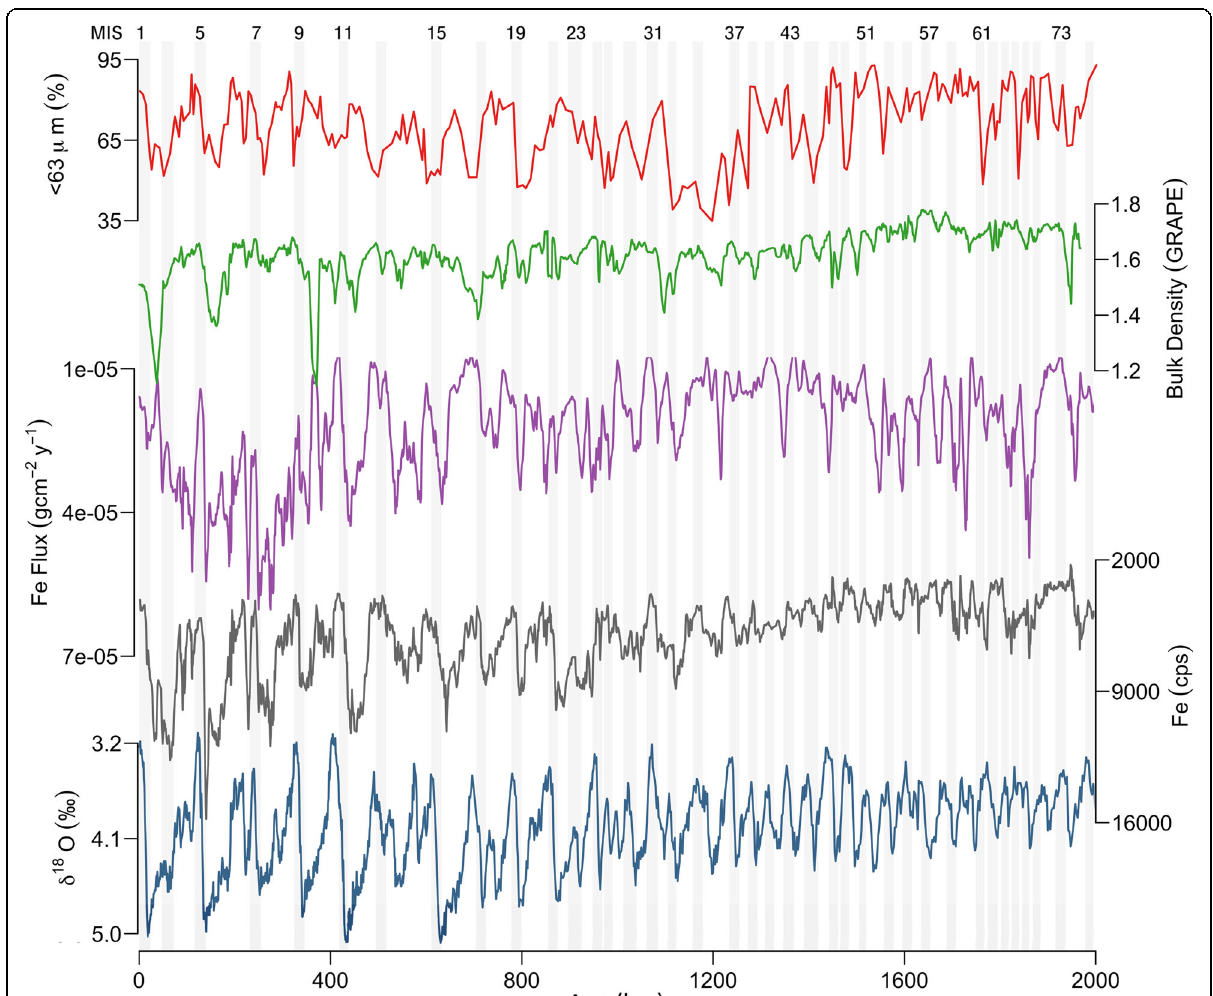
Fig. 13 Clay and silt fraction (< 63 μ m in %), bulk density (Grape data), Fe flux (gm − 2 year − 1 ), Fe intensity (cps = counts per second) and LR04 benthic stable isotope stack against age